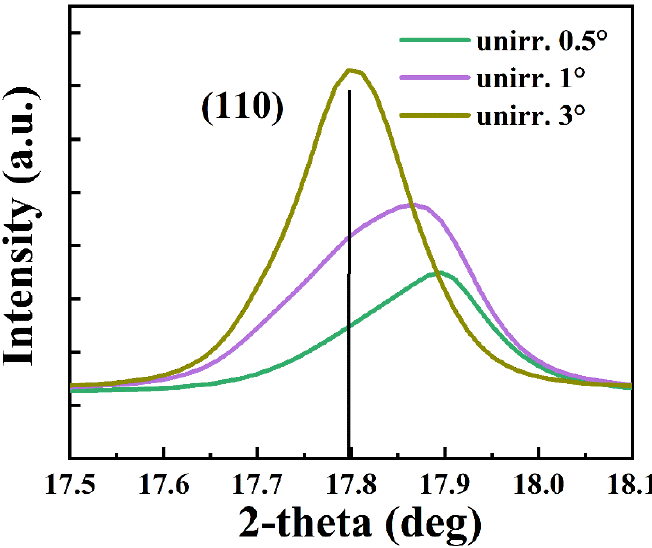
Figure 1. S-GIXRD patterns near the (110) diffraction peak of unirradiated W. The S-GIXRD patterns for the irradiated W at different incident angles from 0.1° to